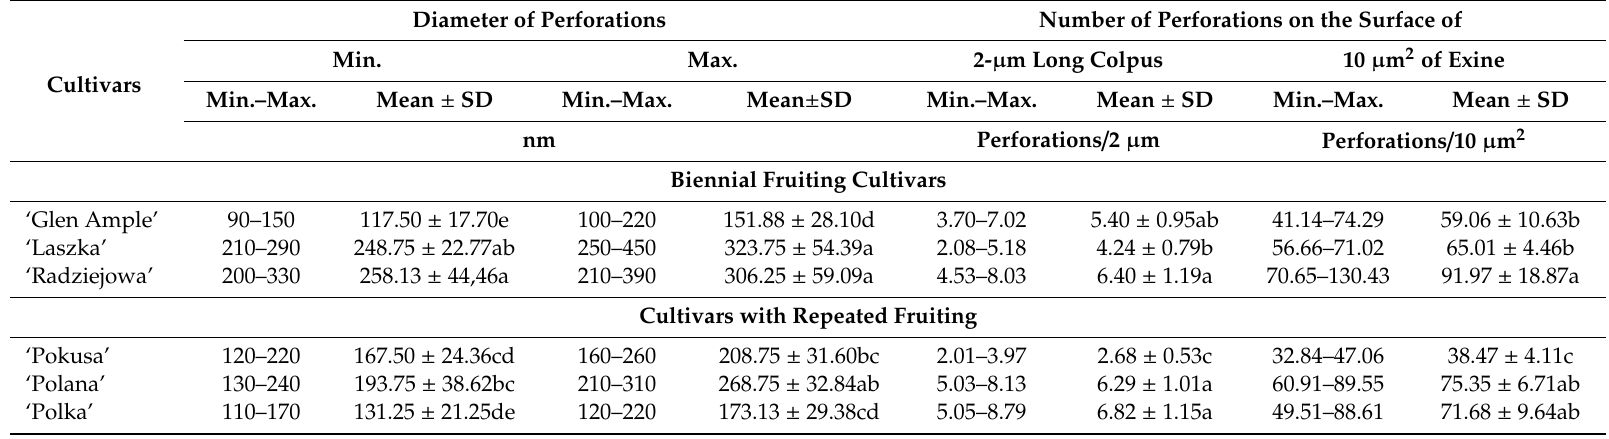
Table 3. Diameter of perforations and number of perforations on a fragment of colpus length and per exine unit area in pollen grains of the examined R. idaeus cultivars. Diameter of Perforations Number of Perforations on the Surface of Min. Max. 2- µ m Long Colpus 10 µ m 2 of Exine Cultivars Min.–Max. Mean ± SD Min.–Max. Min.–Max. Min.–Max.